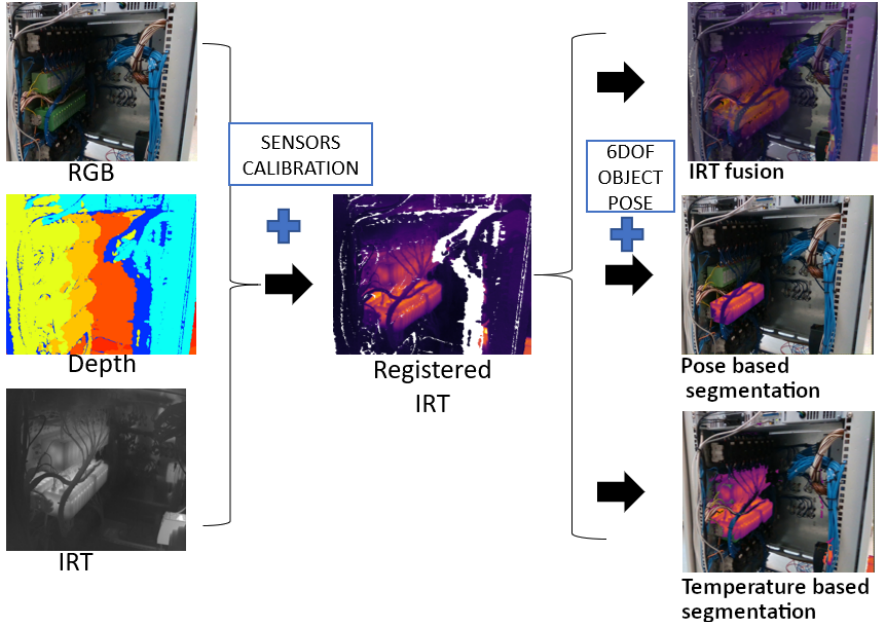
Figure 4. Schematic of the MANTRA system for IRT segmentation based on a temperature range or on a 6DOF object pose of an industrial computer.